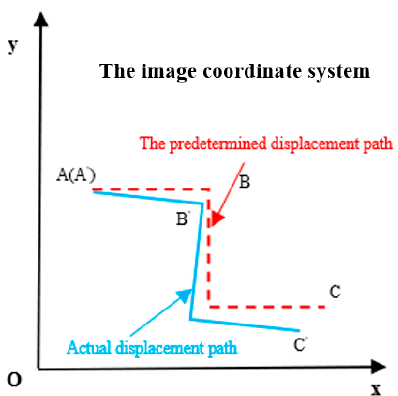
Figure 2. Deviation of displacement path caused by system error. The predetermined displacement path is moved from point A to point C via point B, while the actual displacement path of the platform is moved from point A’ to point C’ via B’ which deviates from the predetermined displacement path due to the system errors.